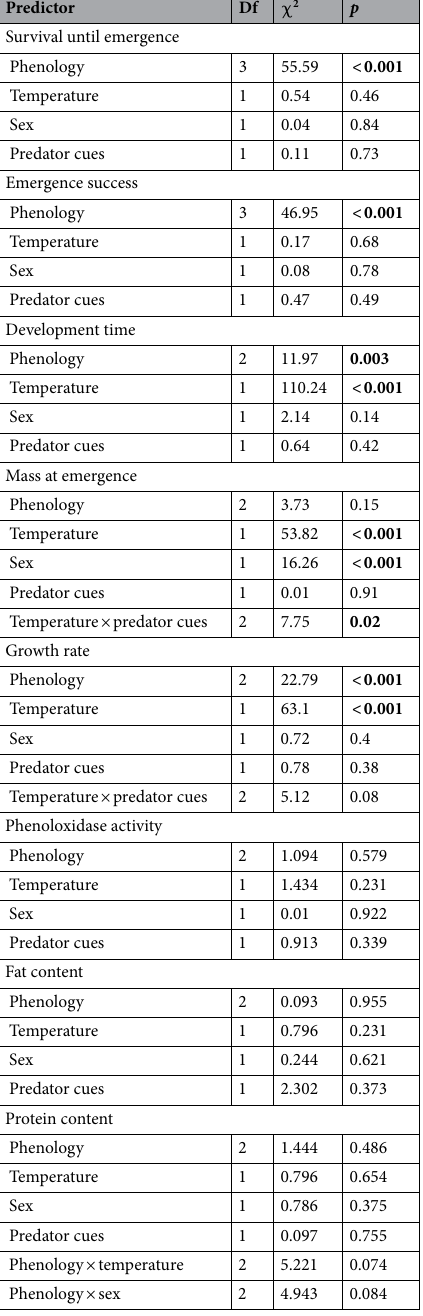
Table 1. Results from mixed models on life history and physiological traits. Final models included all fixed effects and interactions with p -values < 0.1, whereby p -values ≤ 0.05 were considered significant. Except